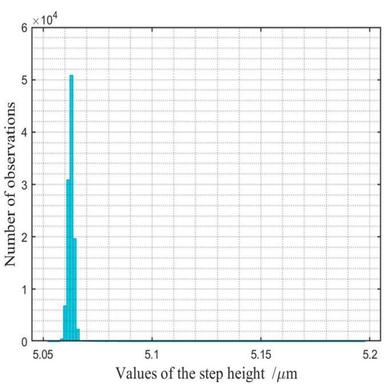
Distributions of the step height values computed by the Centroid-Normal method in Experiment 2.